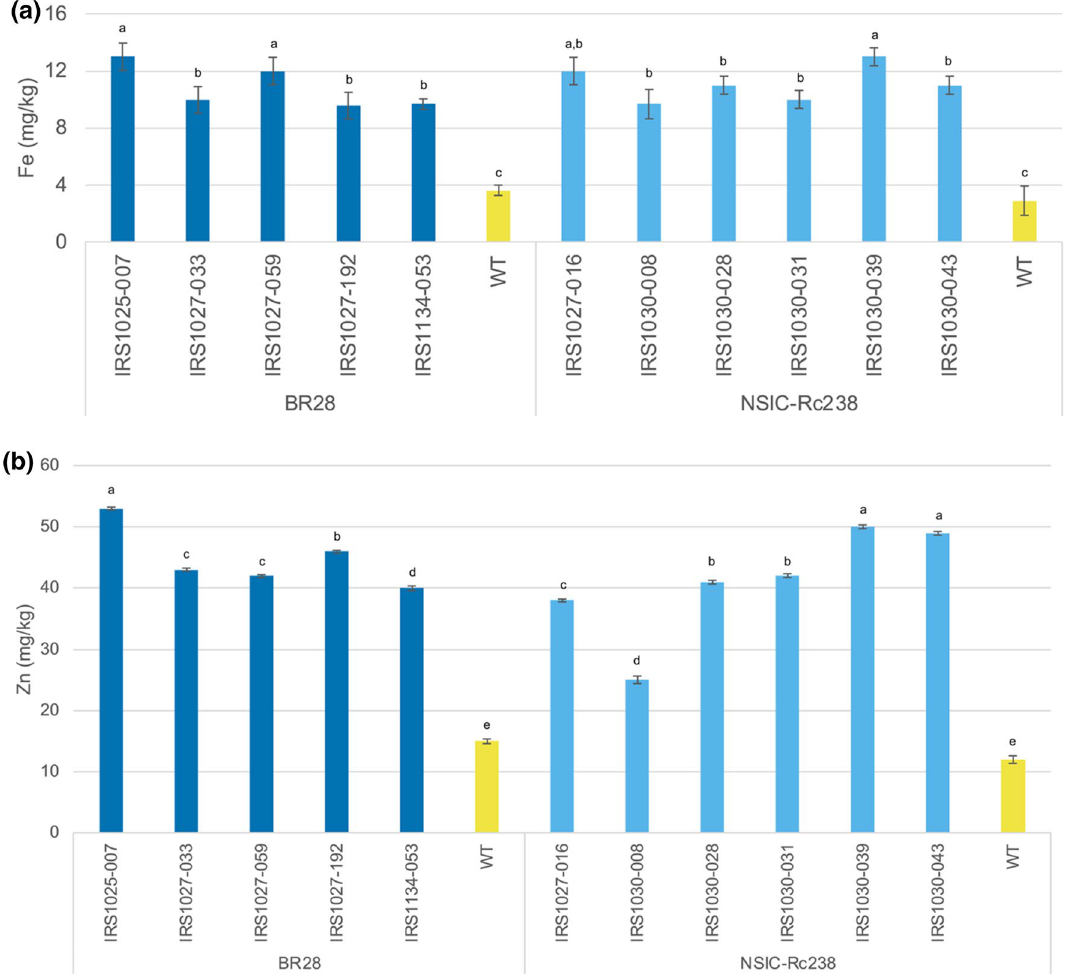
Figure 4. Elemental data for Fe ( a ) and Zn ( b ) were collected through inductively coupled plasma optical emission spectrometry (ICP-OES) of polished rice grains from transgenic events, grown in the screenhouse, in cv. BR28 and cv. Rc238 backgrounds, as well as their respective non-transformed controls. The values represent the mean ± standard deviation (SD) across a bulk of 150 polished grains per respective transgenic event or non-transformed control. Prior submission for elemental analysis the brown rice grains were polished through Kettmill for 55 s. The elemental analysis for all the events was conducted in Analytical Service Laboratory (ASL) at the International Rice Research Institute (IRRI) between 2015 and 2016. Means labeled with different letters differ significantly at the 5% level (Student’s T